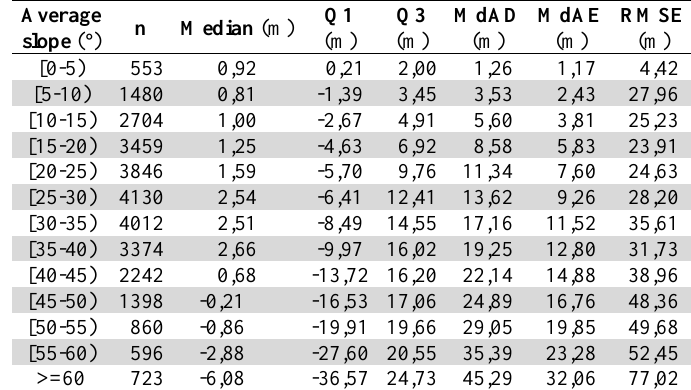
Table. A.1.1 Statistics related to errors from GEDI vs terrain height from discrete lidar divided in slope categories.